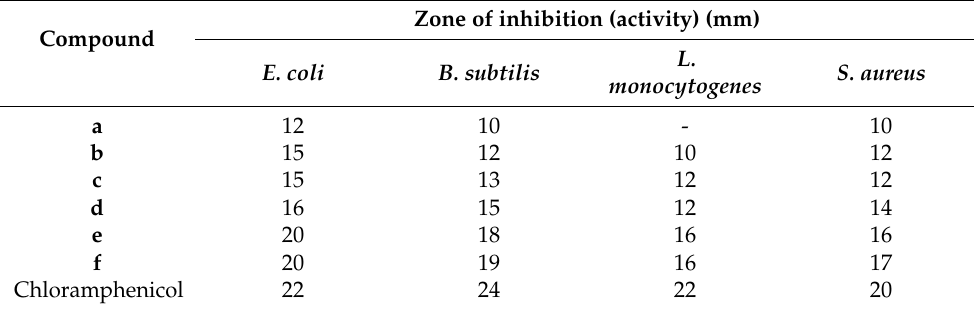
Table 1. The performance of the antibacterial activities of prepared nanomaterials against different bacterial strains.